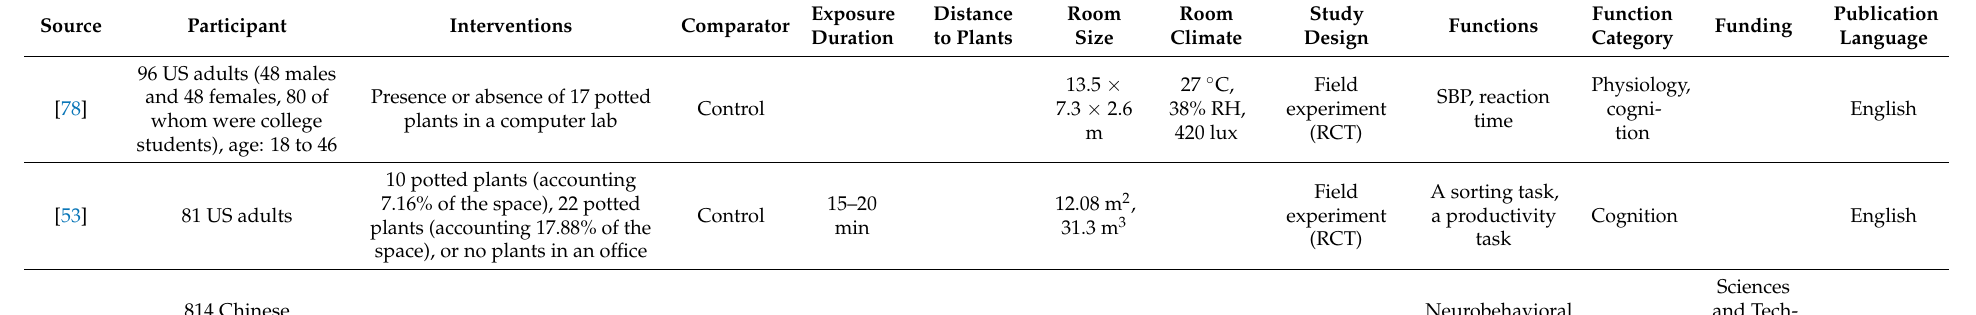
Table 4. Summary of the study characteristics of the